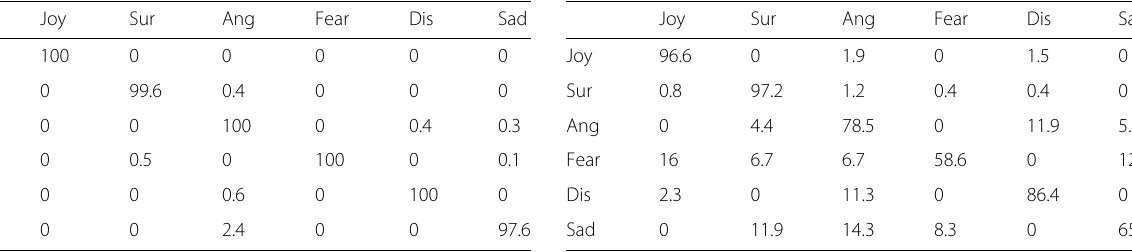
Table 7 Confusion matrix (%) of person independent testing method for 6-class emotion in CK+ dataset using Improved